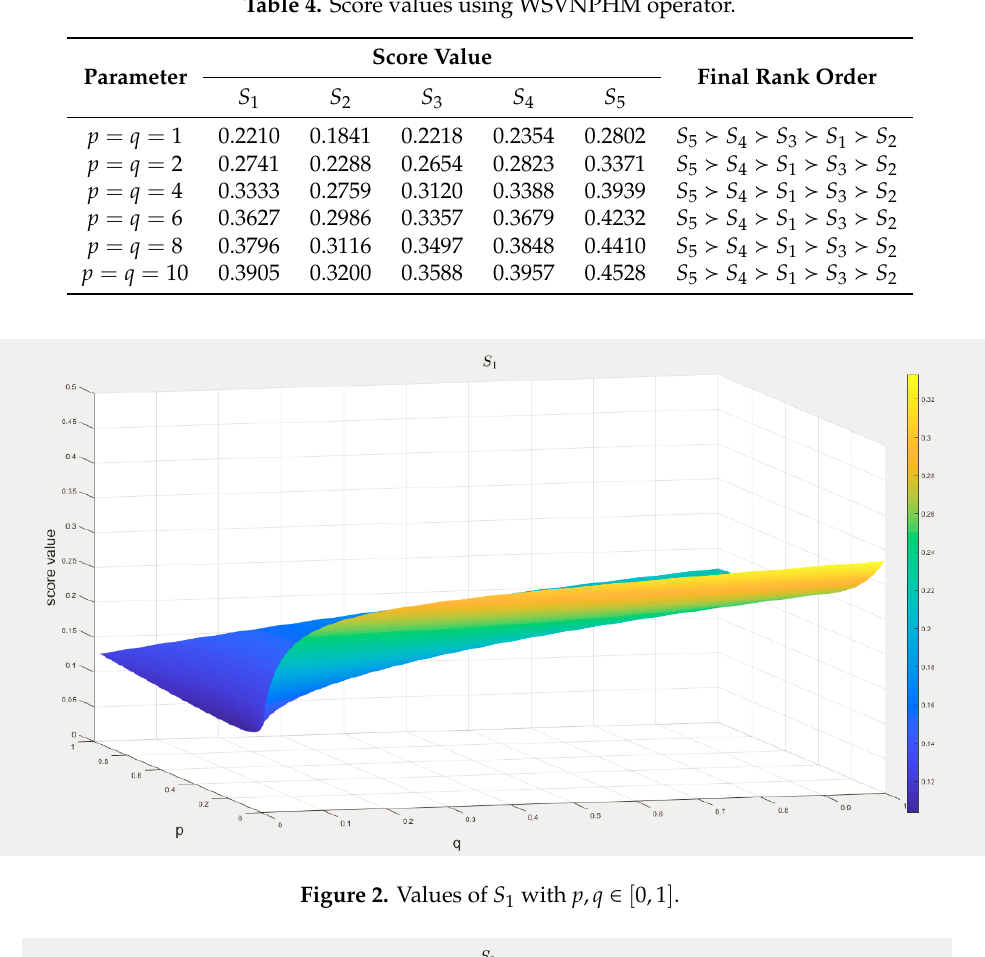
Figure 3. Values of S